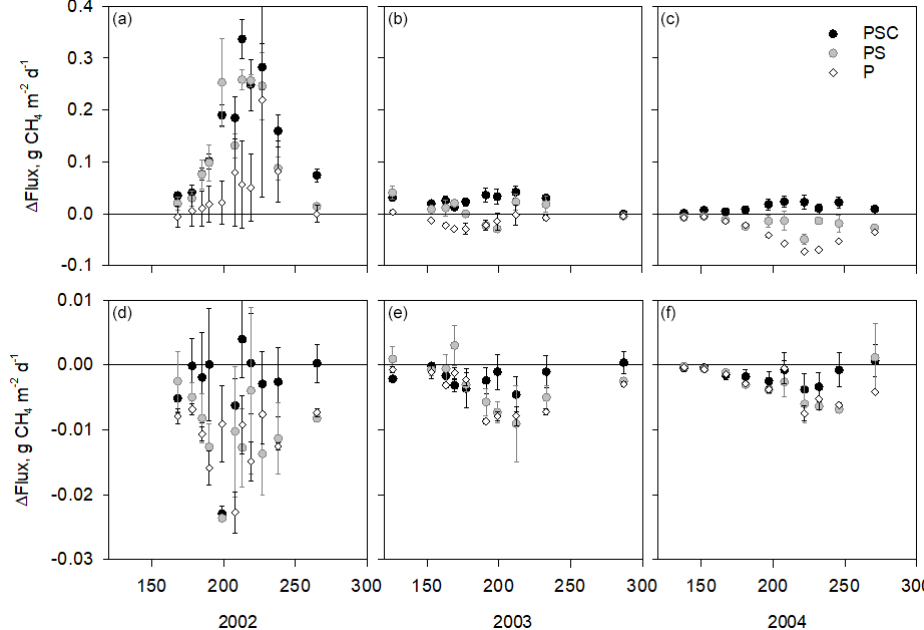
Figure 2. Difference of the measured CH 4 fluxes in plots with plant removal treatments and the mean flux in the plots with intact vegetation on each measurement day at the control subsite (a, b, c) and water level drawdown subsite (d, e, f) . Positive values indicate that fluxes in the plant removal treatment plots are higher than in the intact plots. Units on the x axis give the day of year. Note the difference scales of the y axes in the upper and lower panels. Error bars are standard errors of the mean. Vegetation treatments: PSC – plots consisting of peat, Sphagnum mosses, and sedges (shrubs removed); PS – plots consisting of peat and Sphagnum (sedges and shrubs removed); P – plots consisting of bare peat (all vegetation removed). Intact plots consisted of peat, Sphagnum mosses, sedges, and shrubs. Removal treatments were established in 2002.